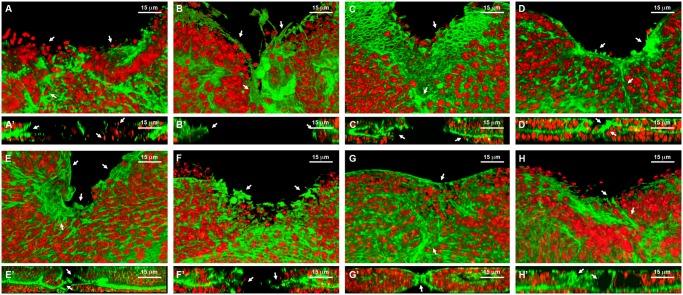
Healing phenotypes categories.3D reconstruction of the peripodial and columnar epithelia at 18 hours after wounding. Phalloidin (actin) is shown in green; DAPI (nuclei) in red. A) Interference with Act42a expression (Class 1 phenotype) results in a large open wound and extensive cell death (arrows). A’) Orthogonal section. No heterotypic contacts, absence of actin cytoskeleton and occasional picnotic nuclei are depicted with arrows. B) Interference with Aats-Val expression (Class 2 phenotype) results in an extensive open wound with actin and active filopodia present at the leading edge (arrows). B’) Orthogonal section. Early approximation of the leading edges but failure on fusion. C) Interference with pvr expression (Class 3 phenotype) results in a large open wound. The CE has initiated healing but the PE fails to heal (arrows). C’) Orthogonal section. Arrows point to the delay on healing of the peripodial epithelia. D) Interference with cpβ expression (Class 4 phenotype) shows a large open wound and abnormal accumulation of actin (arrows). D’) Orthogonal section. Actin accumulation impedes the normal fusion of the epithelia (arrows). E) Interference with scab expression (Class 5 phenotype) shows a large open wound and a gap between the peripodial and the columnar epithelia (arrows). E’) Orthogonal section. The gaps at the edge between layers are more evident. The columnar epithelium initiates sealing apically (arrows). F) Overexpression of mirror (Class 5 phenotype) shows a partial closure and an abnormal distribution of actin (arrows). F’) Orthogonal section. Apical sealing precedes basal attachments that seem disorganized (arrows). G) Interference with fimbrin expression (Class 6 phenotype) displays advanced closure but disorganized actin cytoskeleton in the peripodial epithelia (arrows). G’) Orthogonal section. Actin accumulation at the junction is highlighted. The peripodial epithelia remains disorganized at the fusion point (arrows). H) Interference with arc1 expression (Class 7 phenotype) displays a full closure but shape abnormalities at the junction and adjacent territories (arrows). H’) Orthogonal section. Apical gaps are observed at the fusion area and surrounding. Tissue layers are shifted (arrows). Scale bars are indicated for each panel.